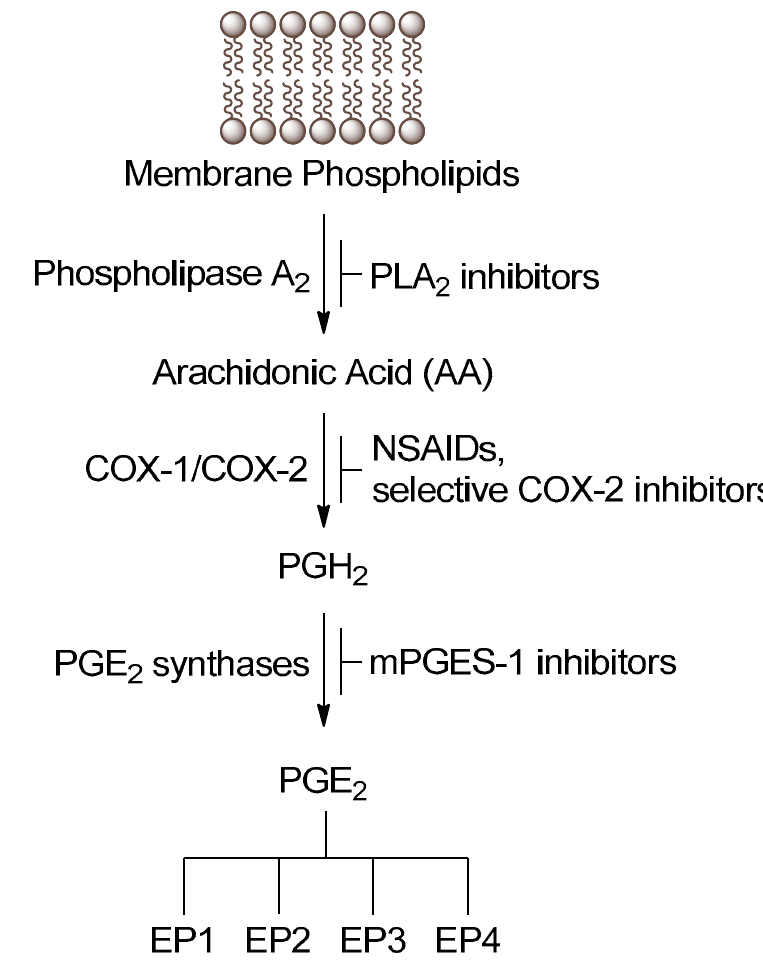
Figure 1. Generation of PGE 2 through metabolism of arachidonic acid.